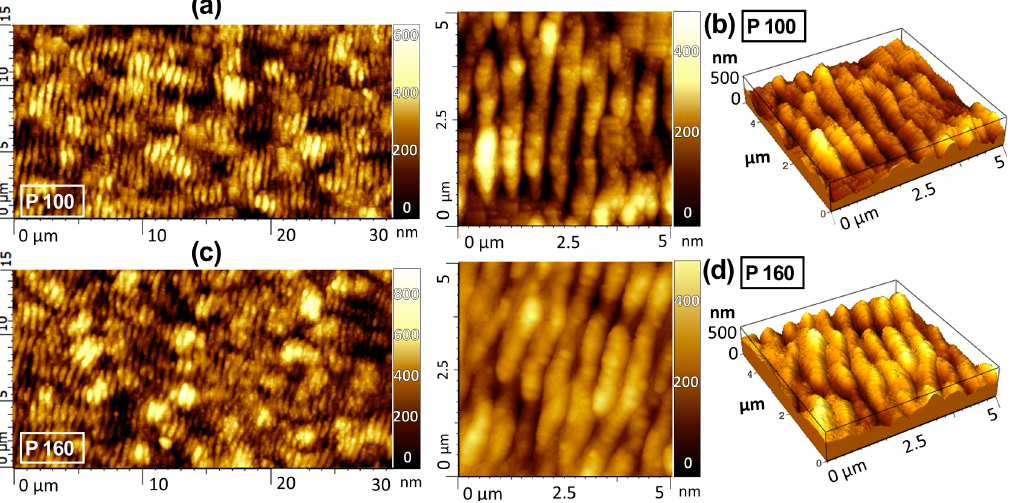
Figure 6. AFM images of sample P100: ( a ) map of 15 × 30 μ m 2 ; ( b ) map of 5 × 5 μ m 2 (shown in both top-view and tilted-view representation), and sample P160: ( c ) map of 15 × 30 μ m 2 and ( d ) map of 5 × 5 μ m 2 (shown in both top-view and tilted-view representation).